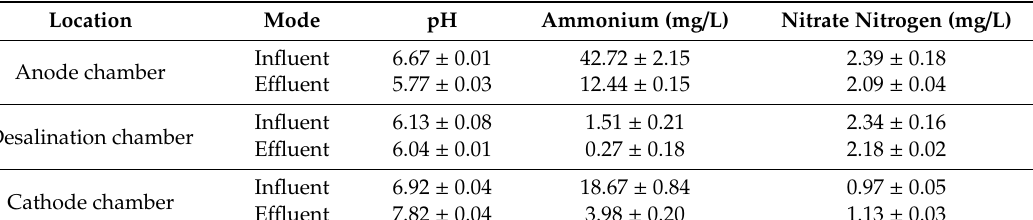
Table 1. Influent and e ffl uent concentrations in inorganic nitrogen concentration of the AMDC.